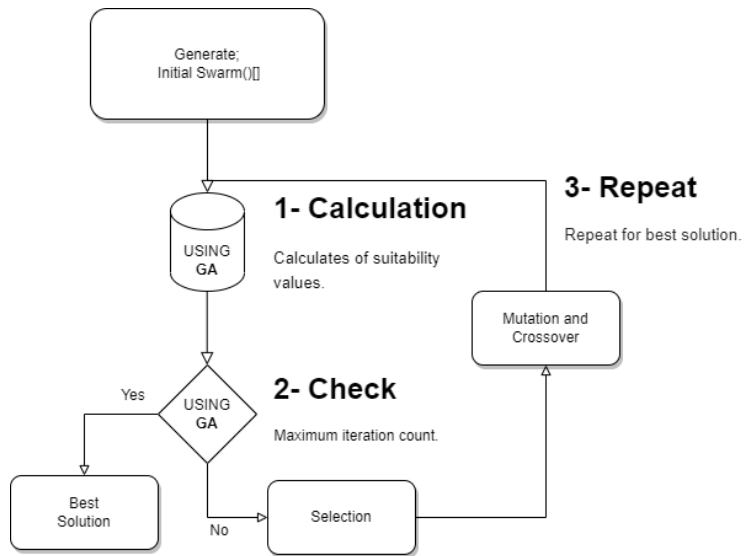
Figure 3. Processing Steps of